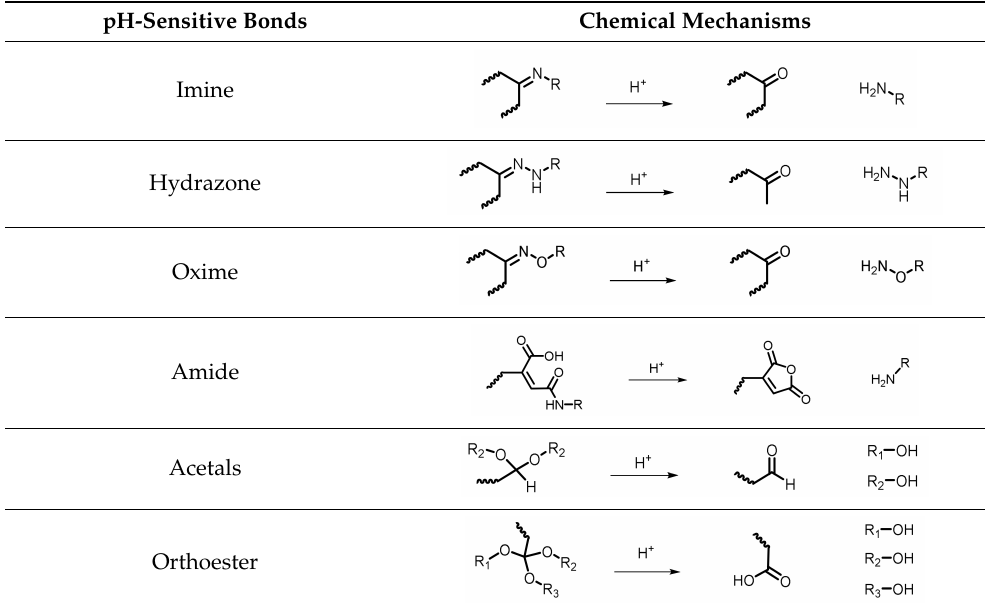
Table 1. pH-sensitive chemical bonds and release mechanisms in acidic conditions. Adapted from [55], published by MDPI,